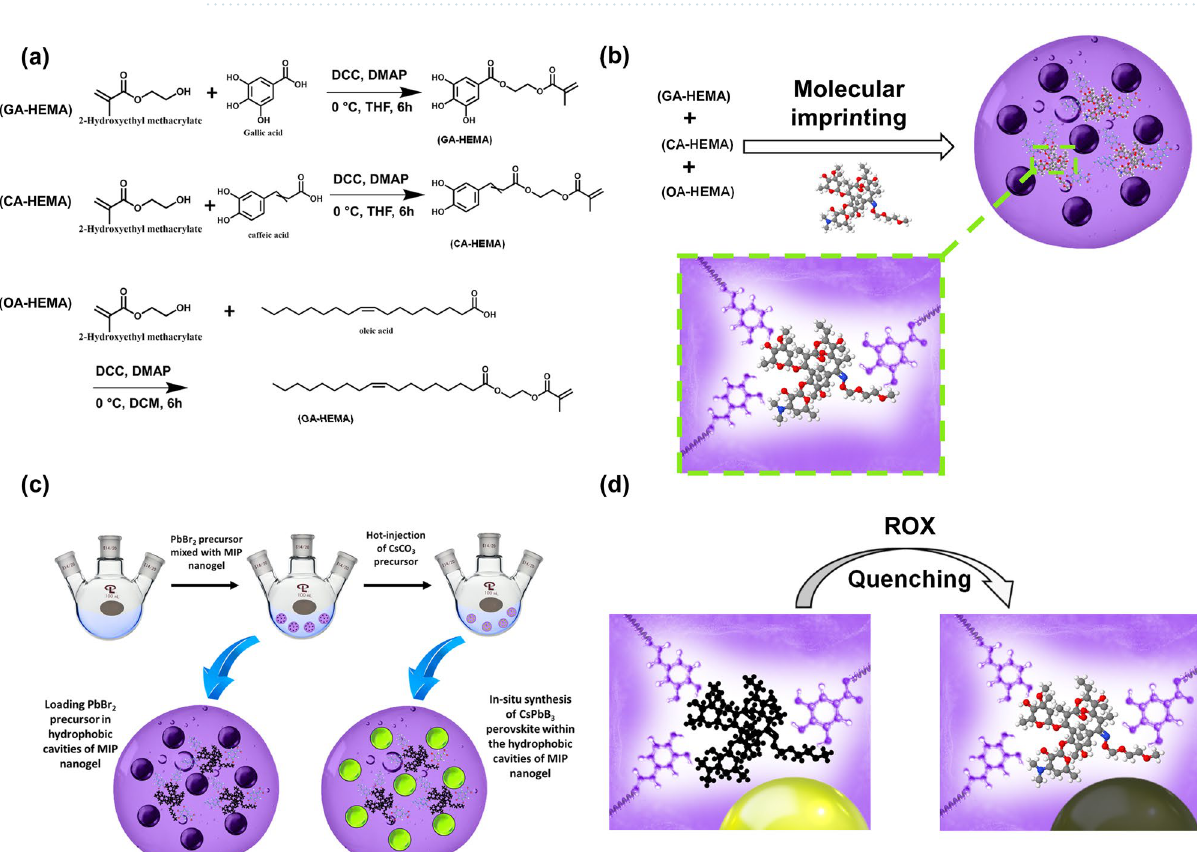
Figure 2. Synthesis and sensing strategies. ( a ) Synthesis of functional HEMA monomers. ( b ) Synthesis of MIP nanogels. ( c ) Loading CsPbBr 3 perovskite nanoparticles into MIP nanogels. (d) Sensing of